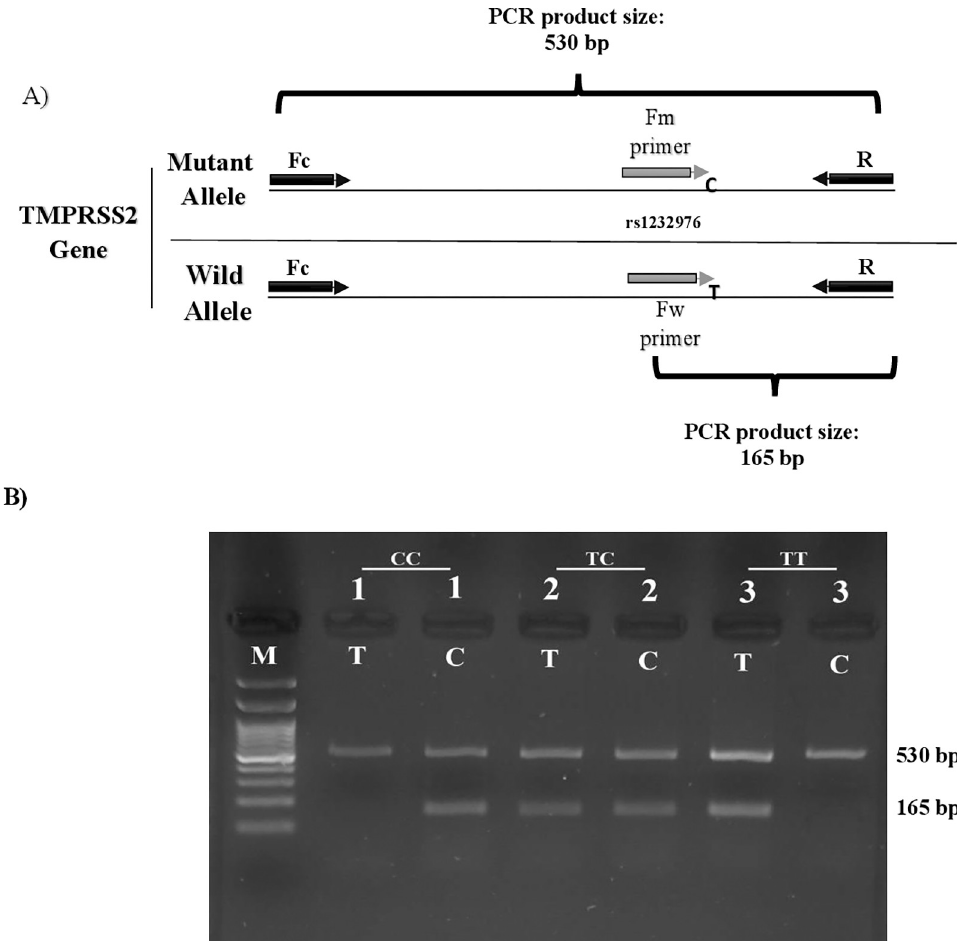
Fig 1. TMPRSS2 rs12329760 genotyping by ARMS- PCR. A) Schematic diagram for primers positions in TMPRSS2 gene. In each PCR reaction, Fc and R primers produced 530 bp PCR product as internal control. The amplicon size for the allele-specific primers (Fw or Fm), was 165 bp. B) Amplified products of 3 patients after agarose gel electrophoresis shows three different genotypes. For each DNA sample, two ARMS-PCR reactions were conducted for detecting C and T alleles and the genotype of each patient defined above each pair of lanes. Lane M 100 bp ladder.